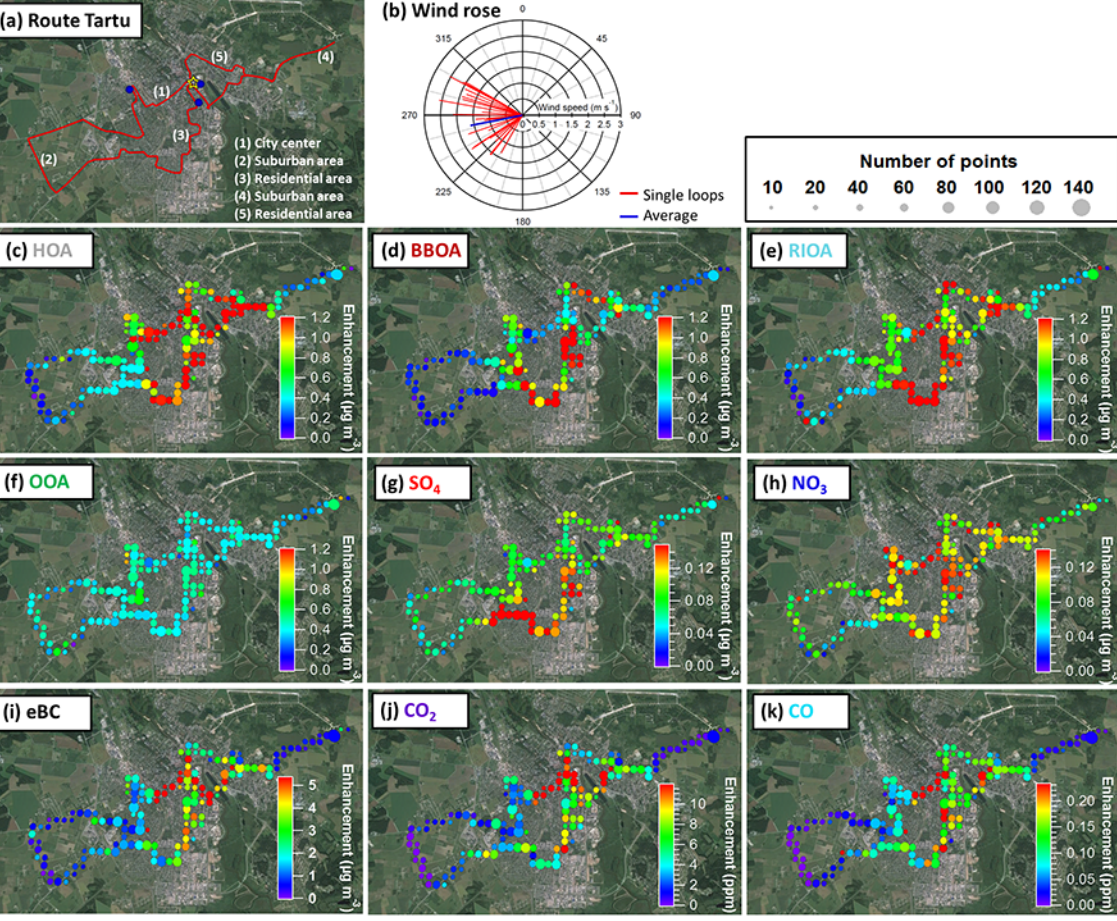
Figure 4. (a) Driving route in Tartu: the red trace represents the GPS data, the yellow star the stationary measurements location, and the blue dots the monitoring stations of the Estonian Environmental Research Institute (EERC); (b) wind conditions during the mobile measurements in Tartu: red traces represent the wind direction and speed for the single loops and the average of all loops is represented in blue; ( c to k ) average spatial distributions of all identified OA sources (panels c to f ) and other measured components (panels g to k ) in Tartu. The color scales represent enhancement over the background concentrations; the maximum of the color scales is fixed to the 75th percentile of the average enhancement of each component in panels (g) to (k) and to the highest 75th percentile among all OA sources in panels (c) to (f) . The sizes of the points represent the number of points that were averaged in each